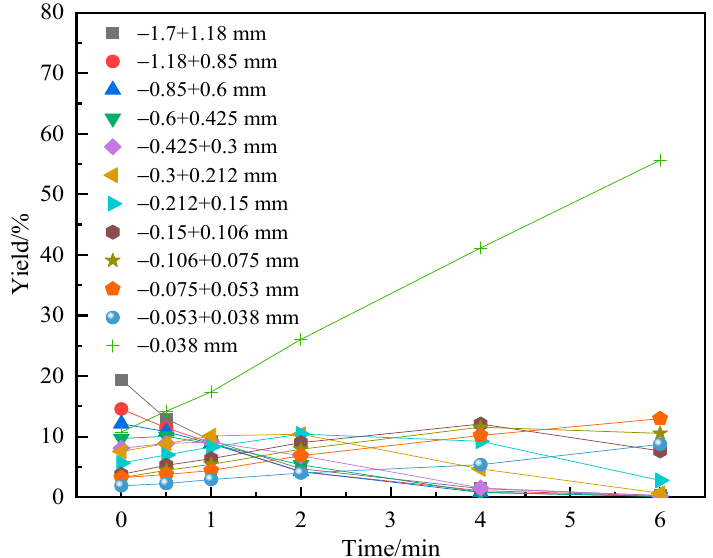
Figure 6. Product particle size composition of Tongkeng ore at different grinding times.